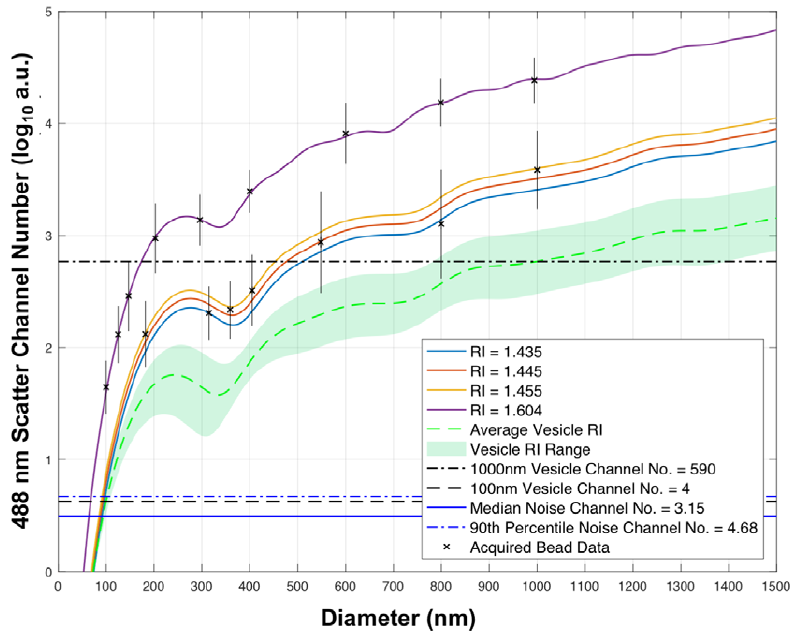
Figure 1. Scatter-diameter relationship of acquired vs. predicted polystyrene and silica particles on Astrios EQ. Predicted scattering cross-sectional units were normalized to flow cytometer arbitrary unit data using a single normalization factor. Error bars show the range of the acquired bead scattering in arbitrary units, with crosses indicating median acquired scattering of each bead. The green lines represent the range of EV refractive indices (inner refractive index n=1.38 ± 0.02, 140 Sensors 2017 , 17 , x FOR PEER REVIEW membrane refractive index n=1.48, and a membrane diameter of 10 nm). The scattering power of 100 141 nm and 1000 nm EVs, assuming an average refractive index, are also shown (black lines). Instrument 142 noise floor statistics are also displayed (blue lines). 143